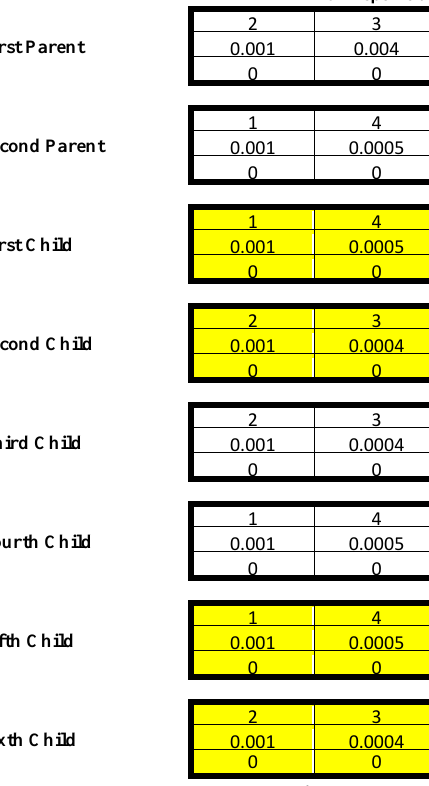
Fig. 3. Crossover